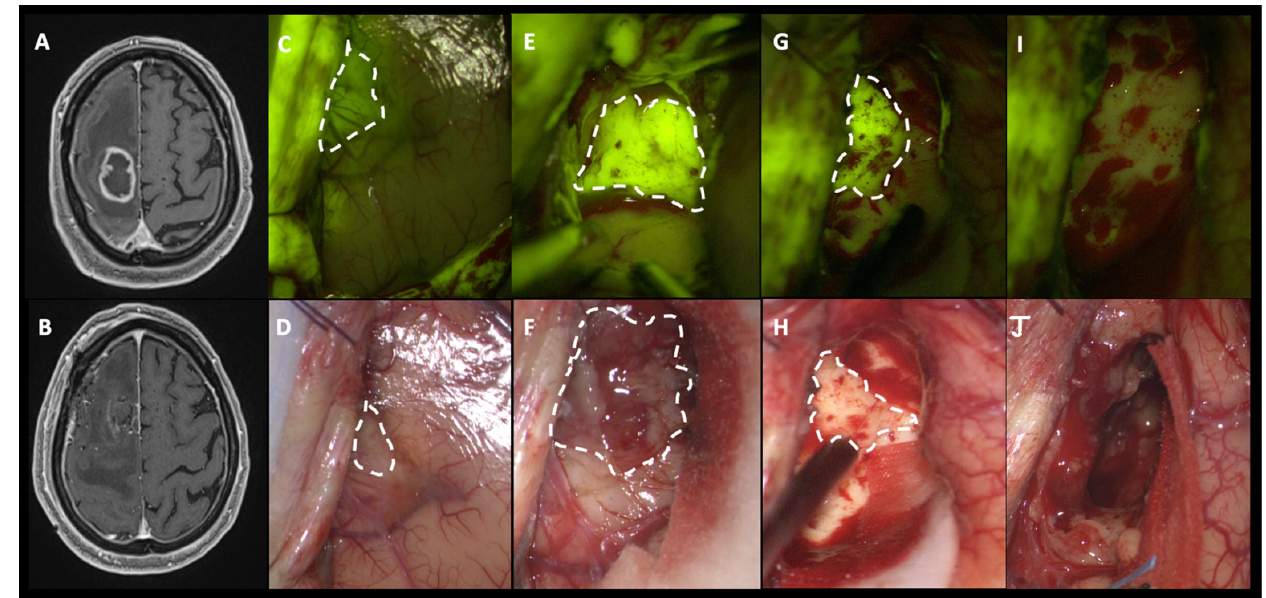
Figure 2. ( A ) Preoperative post-contrast axial T1-weighted MRI scan showing a right frontal GBM that was completely removed, as visible in post-operative T1 with a contrast axial scan ( B ). Intraoperative images, under YELLOW 560 filter ( C , E , G ), depict a bright yellow-green signal (dotted lines) in correspondence to the pathological components; the corresponding images are shown and compared under white light visualization (dotted lines in ( D , F , H )): at the beginning of surgery ( D ), it is possible to appreciate a grayish, vanishing area which corresponds to the cortical projection of pathological tissue but during surgical resection, fluorescein becomes fundamental in helping the surgeon to identify residual pathological tissue (dotted line in ( G )), not clearly visible under white light ( H ). ( I , J ) At the end of the resection, the cavity did not show any sign of residual tumor, as confirmed by fluorescent visualization with the YELLOW 560